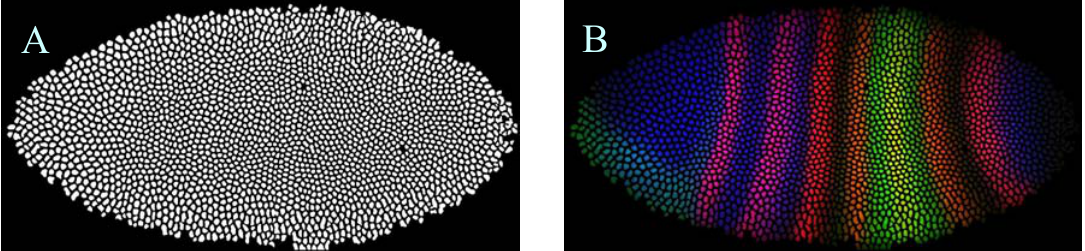
Figure 3. Visualization of expression patterns of genes scanned in embryo dr2. The greyscale images of expression patterns of genes even-skipped (A) , hunchback (B) and knirps (C) obtained with confocal microscope. (D) The resultant color image with even-skipped in red, hunchback in green and knirps in blue. Images are from FlyEx database, image in D is generated on-the-fly by ImageServer.